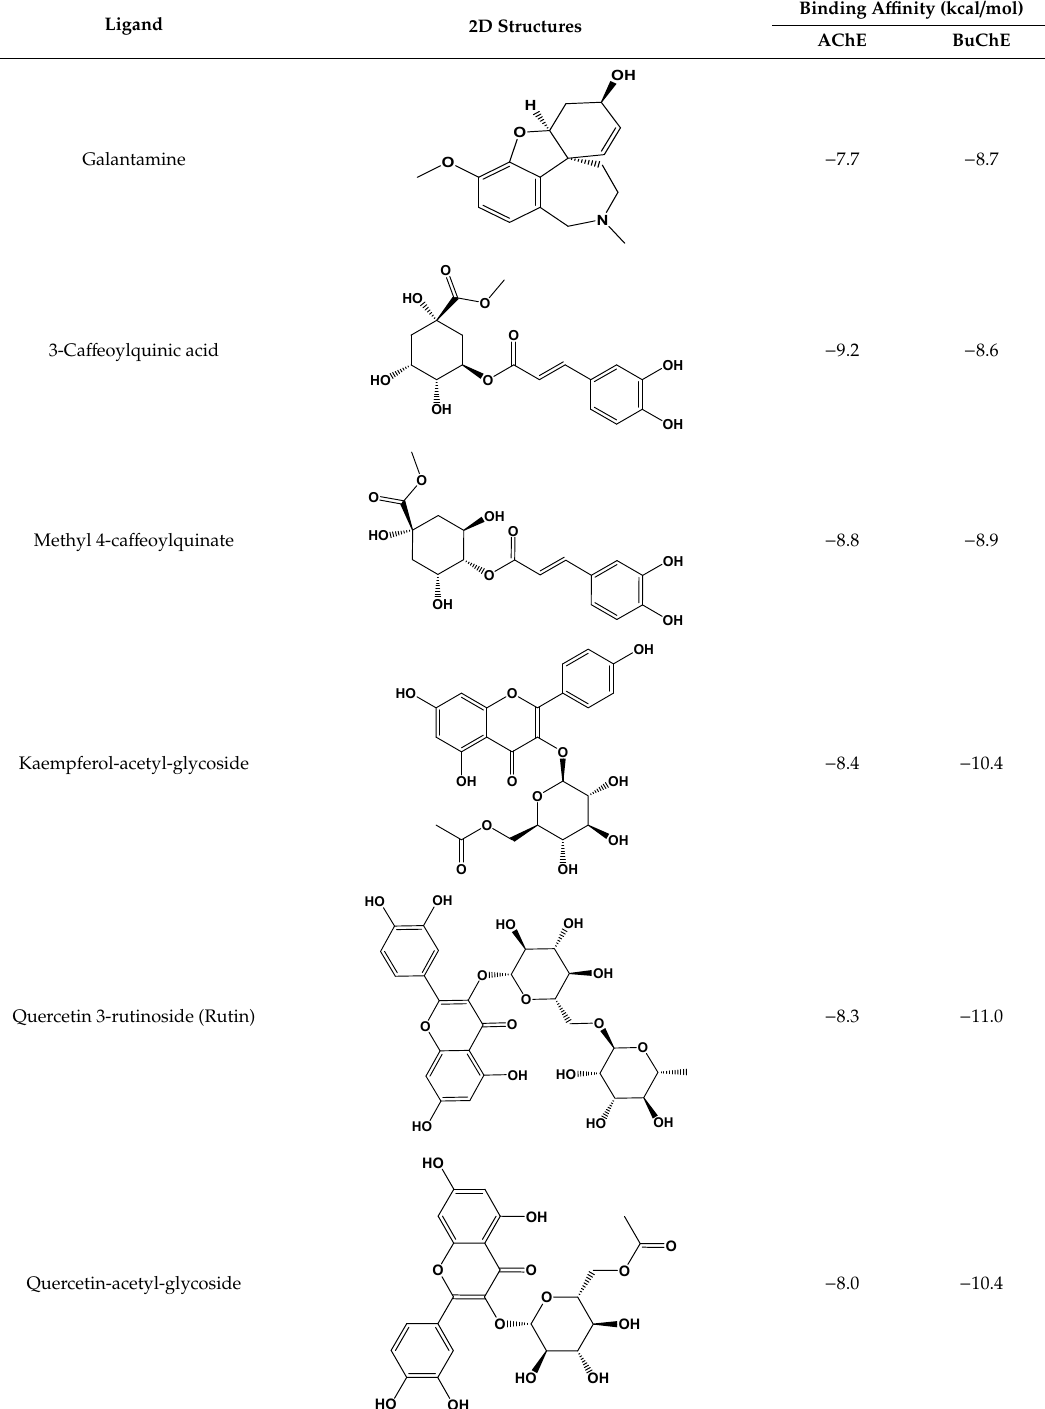
Table 3. AChE and BuChE binding characteristics of the plant phytochemicals.